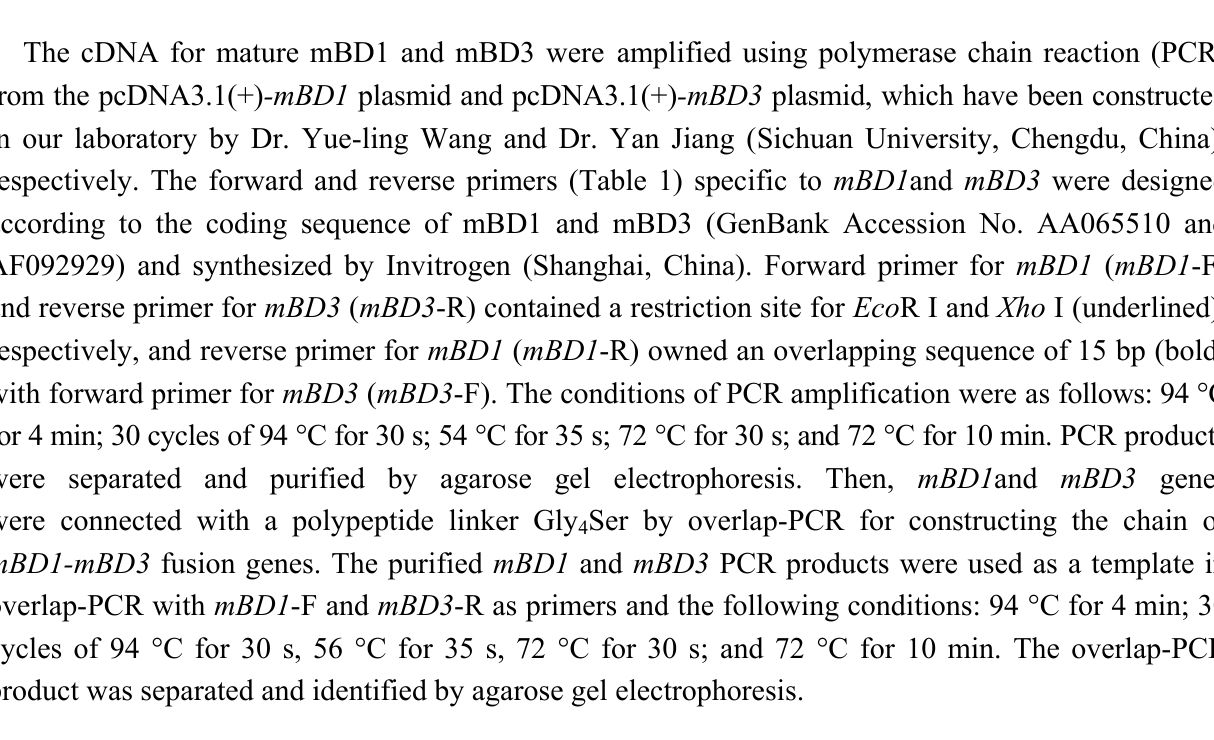
Table 1. Primers used for the amplification of mBD-1 and mBD-3